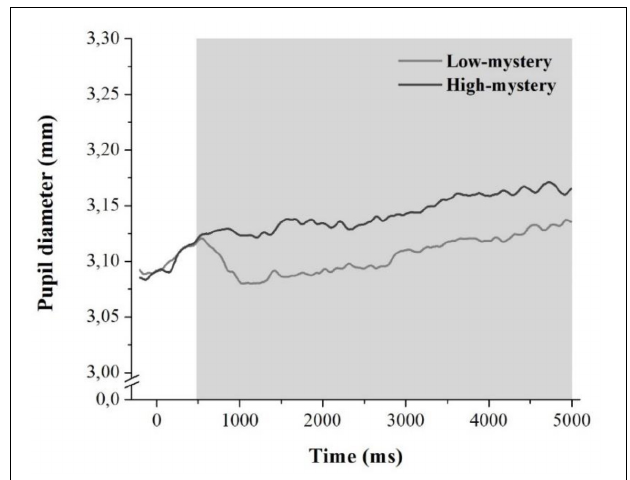
FIGURE 2 | Variation of the mean pupil diameter (in mm) as a function of time (in ms) for both low-mystery (solid gray line) and high-mystery trials (solid black line) averaged across all participants. Time 0 represents the onset of the image that is displayed for 5,000 ms. The gray area represents the time-window during which the mean tonic pupil diameter was